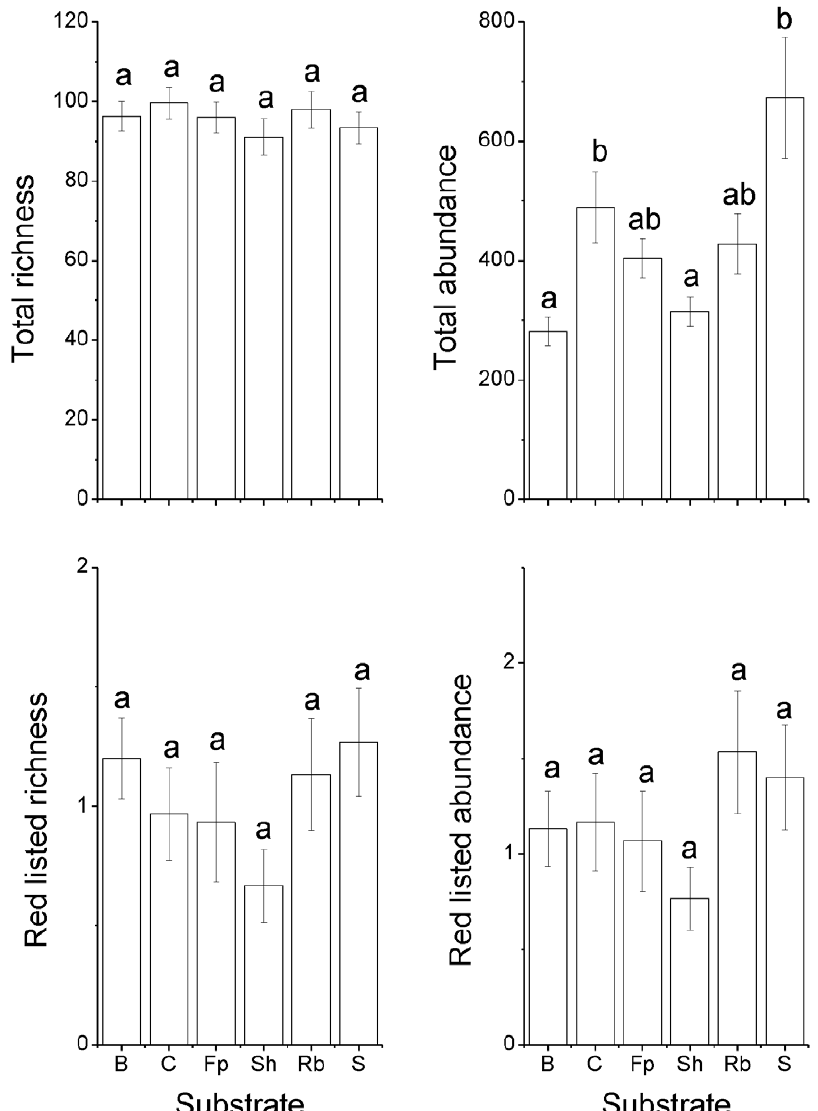
Figure 1. Abundance and species richness in the six different substrate types. Vertical bars shows 6 1 SE. Bars with different letters denote statistically significant effects (Tukey test, p , 0.05). Abbreviations: B=burned, C=control, Fp= Fomitopsis pinicola , Rb= Resinicium bicolor , Sh=shaded, S=snag. Vertical bars shows 6 1 SE.